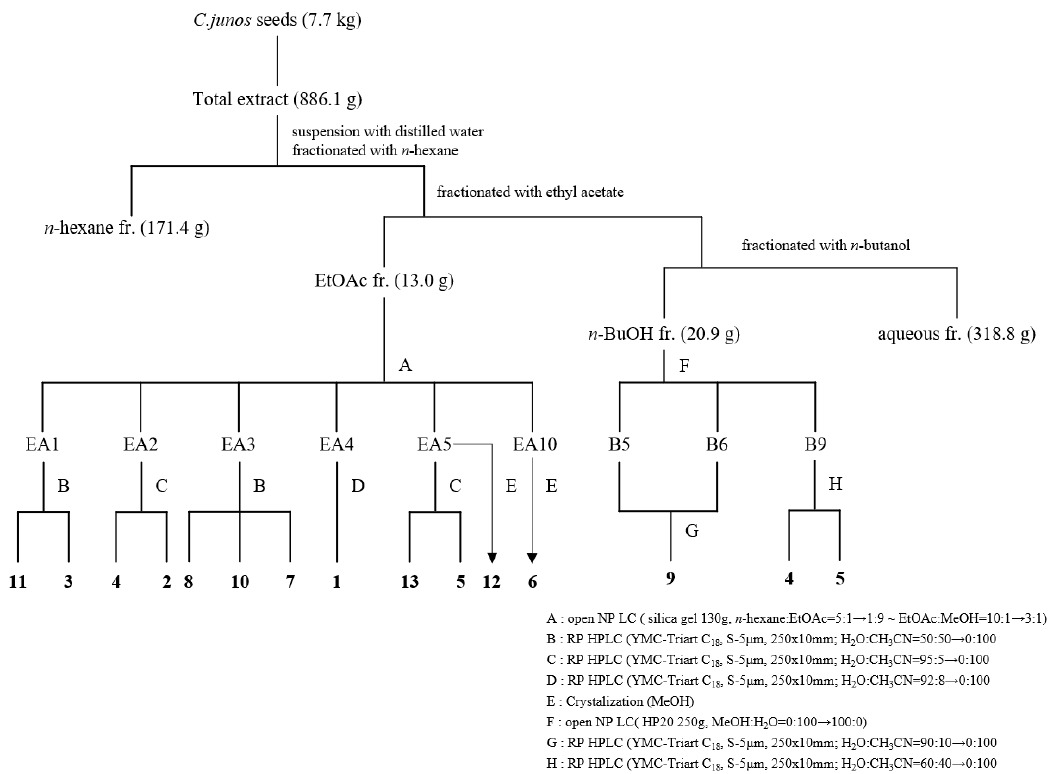
Figure 1. Isolation of limonoids from C. junos seeds. Twelve limonoids were isolated from the ethyl acetate fraction while three were isolated from the n -butanol fraction.